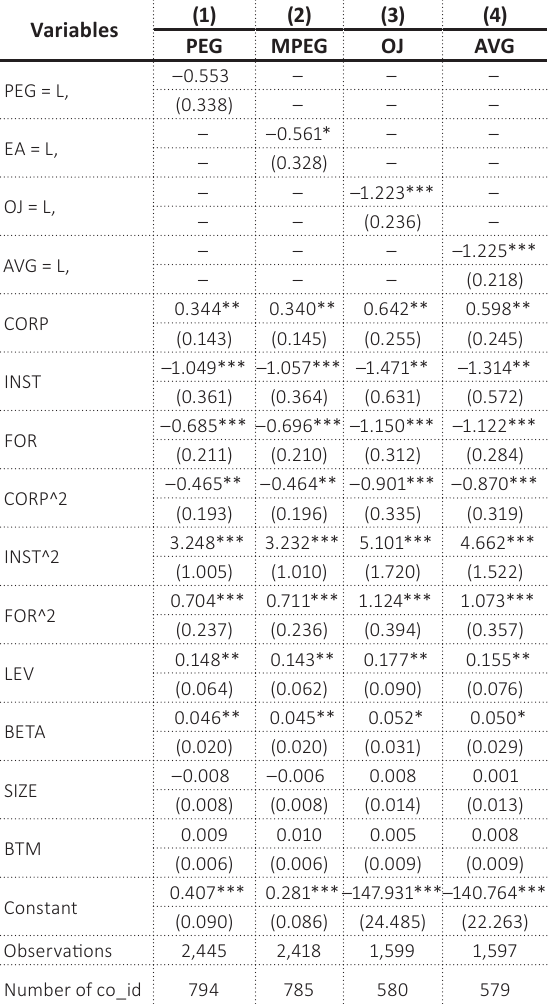
Table 3. Robustness check of holding variables on ICC models using a two-step system GMM